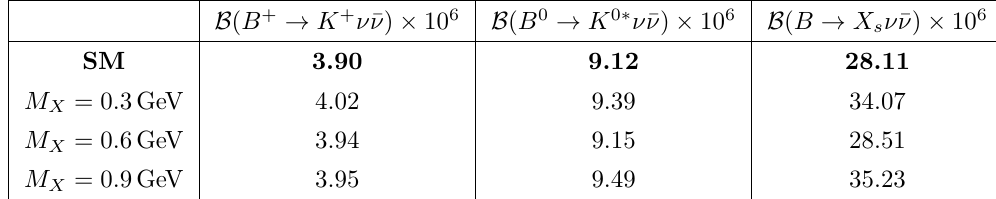
Table 2 . Predictions for the SM and NP branching fractions for the rare B-meson decay to a pair of neutrinos. The NP branching fractions are mentioned for three different light gauge boson masses considering g X = 10 − 3 , (cid:15) = 10 − 4 and U(1) X charges as mentioned above. is in good agreement with the flavour data as shown in figure 5. For n = 2 , n = − 1 , 2 1 the correlation between M and g is shown in figure 6, here we have shown the region X X . 1 . 0 (GeV). For these values of [ n 0 . 25 . M , n ] and for g = 0 . 001 , within the allowed 2 1 X X ranges of q 2 and M the numerical values of the WCs ∆ C µ and ∆ C e will lie in between X 9 9 [ − 0 . 827 , − 1 . 83] and [0 . 413 , 0 . 91] , respectively. These values of the WCs are consistent